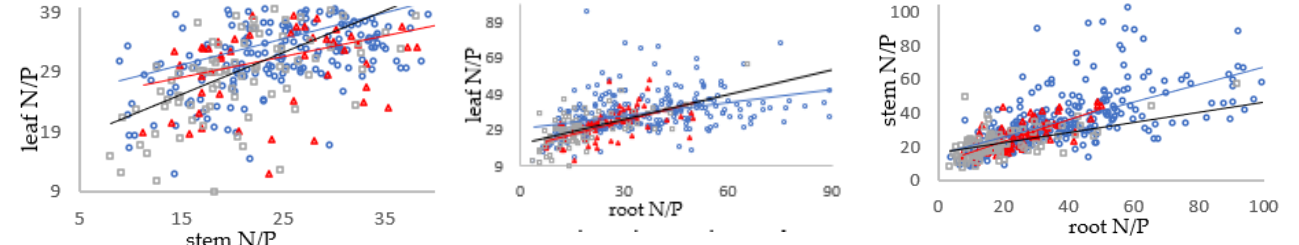
Figure 6. Relationships between N/P in shrub organs for different mycorrhizal types. The blue cycles and blue lines mean AM, the red triangles and red lines mean AM + ECM, and the gray squares and black lines mean ECM.